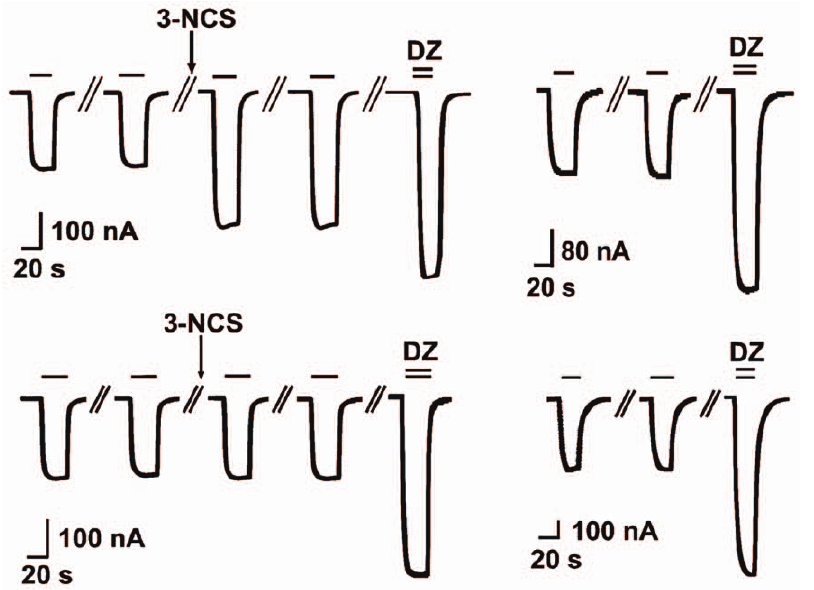
Figure 5. Covalent reaction at the functional level. Exposure of mutated a 1 S205C b 2 c 2 receptors to 3-NCS results in a covalent reaction. a) Receptors were exposed twice to 0.5 m M GABA followed by a washing period and a 3 min incubation in 10 m M 3-NCS. After this treatment GABA was applied twice with a 3 min interval. In some experiments GABA was applied up to six times. Thus, the current elicited by GABA was stimulated irreversibly. Application of 0.5 m M GABA in combination with 1 m M diazepam results in a further stimulation of the partially irreversibly reacted receptors that was smaller than that seen upon b) direct exposure to diazepam in independent experiments. Exposure of a 1 T204C b 2 c 2 receptors 3- NCS does not result in a covalent reaction. c) Receptors were exposed twice to 0.5 m M GABA followed by a 3 min incubation in 10 m M 3-NCS. Application of 0.5 m M GABA in combination with 1 m M diazepam results in stimulation similar to the stimulation seen in an oocyte that had not been previously exposed to 3-NCS (Fig. 4d).